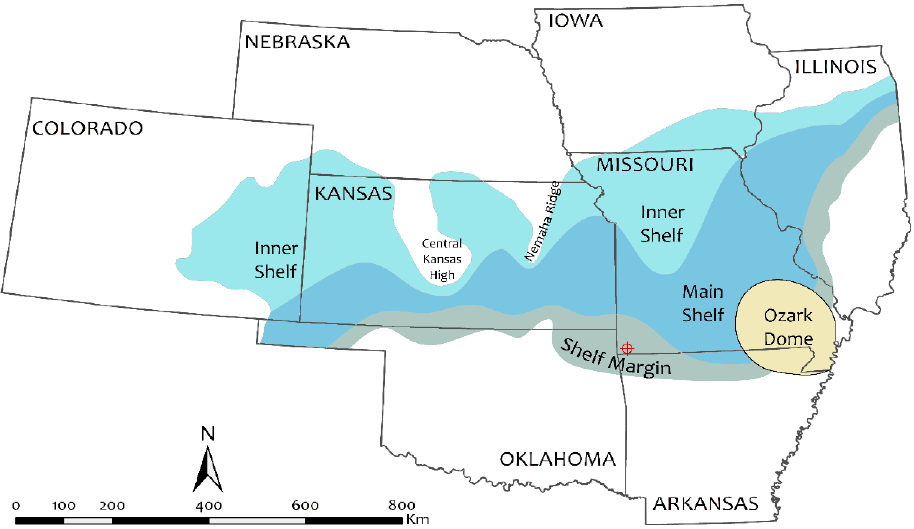
Figure 1. Paleogeography and lithofacies distribution of the Lower Mississippian. The area studied in this study, which falls within the Shelf Margin, is depicted by the crosshair in southwest Missouri. (modified after [36]).